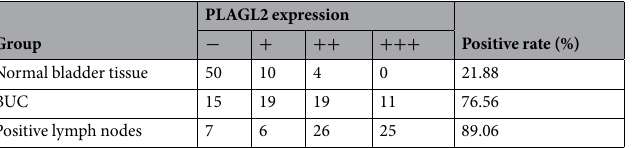
Table 2. The expression of PLAGL2 in BUC, positive lymph nodes, and normal bladder tissue. Note: BUC vs. Normal bladder tissue, P < 0.05; Positive lymph nodes vs. BUC, P < 0.05; P ositive lymph nodes vs. Normal bladder tissue, P <